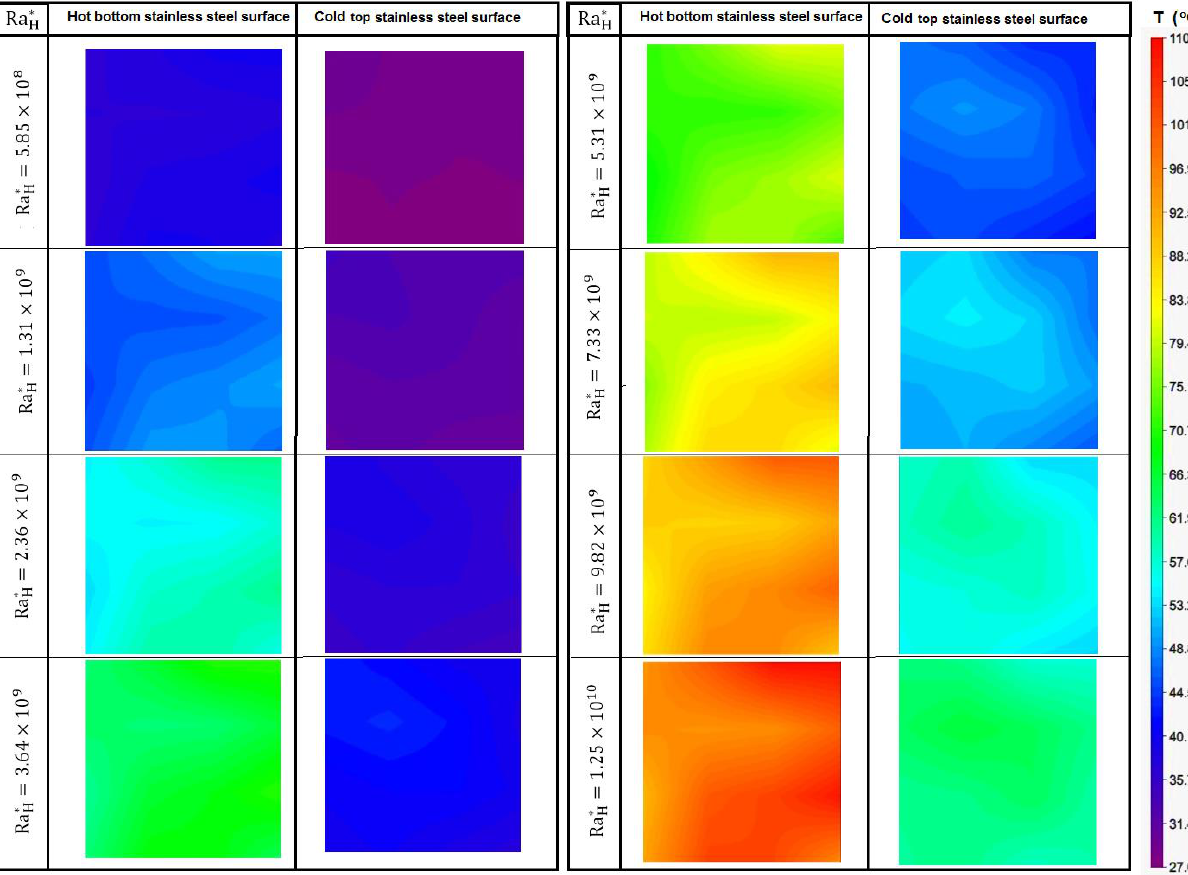
Processes 2022 , 10 , 396 Figure 5. Surface temperature contours of the stainless steel on the cold and hot surfaces.